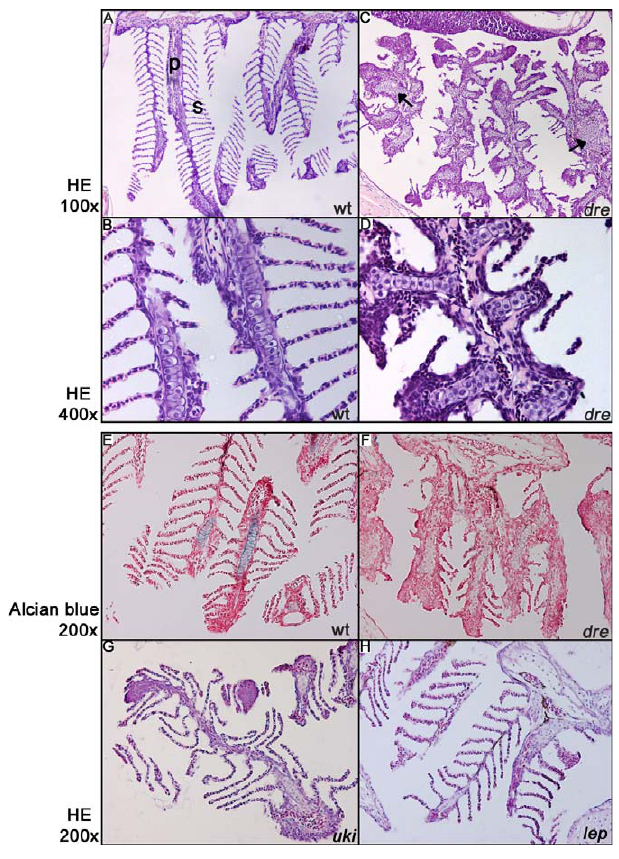
Figure 3. Patterning of the Branchial Arches in a 5-Mo-Old dre Mutant (A and B) The strict organization of the brachial arch into primary (p) and secondary (s) lamellae in a wild-type situation (100 3 magnification). Higher magnification shows stacks of single chondrocytes in the primary lamellae. (C and D) Sectioning of a dre mutant shows disturbed patterning, resulting in the absence of secondary lamellae and the presence of foci of chondrocyte-like cells in the primary lamellae (arrowsHE, hematoxylin and eosin stain; wt, wild-type. (E and F) Alcian Blue staining reveals the presence of differentiated chondrocytes in the wild-type (wt) primary lamellae, but not in the dre mutant, indicating that the differentiation of these chondrocytes is affected (200 3 ). (G and H) Branchial arches of uki and lep mutants appear to be wild-type